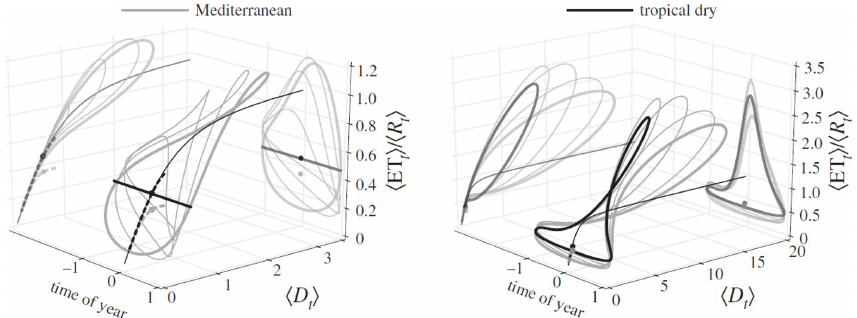
Figure 3. Transient trajectories of the time-varying ratio (cid:104) ET t (cid:105) / (cid:104) R t (cid:105) as a function of the time-varying dryness index (cid:104) D t (cid:105) and time of year for Mediterranean and tropical dry climates. Brackets indicate ensemble averages for a given time of year, taken over the rainfall variability due to a time-dependent (i.e., seasonal) marked Poisson process of rainfall and seasonal potential evapotranspiration. Each loop is derived from the same climate inputs, with the exception of the phase difference between rainfall and potential evapotranspiration, with the thick grey lines showing results for out-of-phase and thick black lines for in-phase. The + 1 on the time-of-year axis corresponds to when maximum rainfall occurs (wet season), and − 1 corresponds to timing of minimum rainfall (dry season). The annual average value for each loop falls on a single point on the annual Budyko curves, shown as dashed lines (black and grey) for those that account for climate seasonality and as thin black lines for the classical curve which considers only annually averaged climate values. After Feng et al.